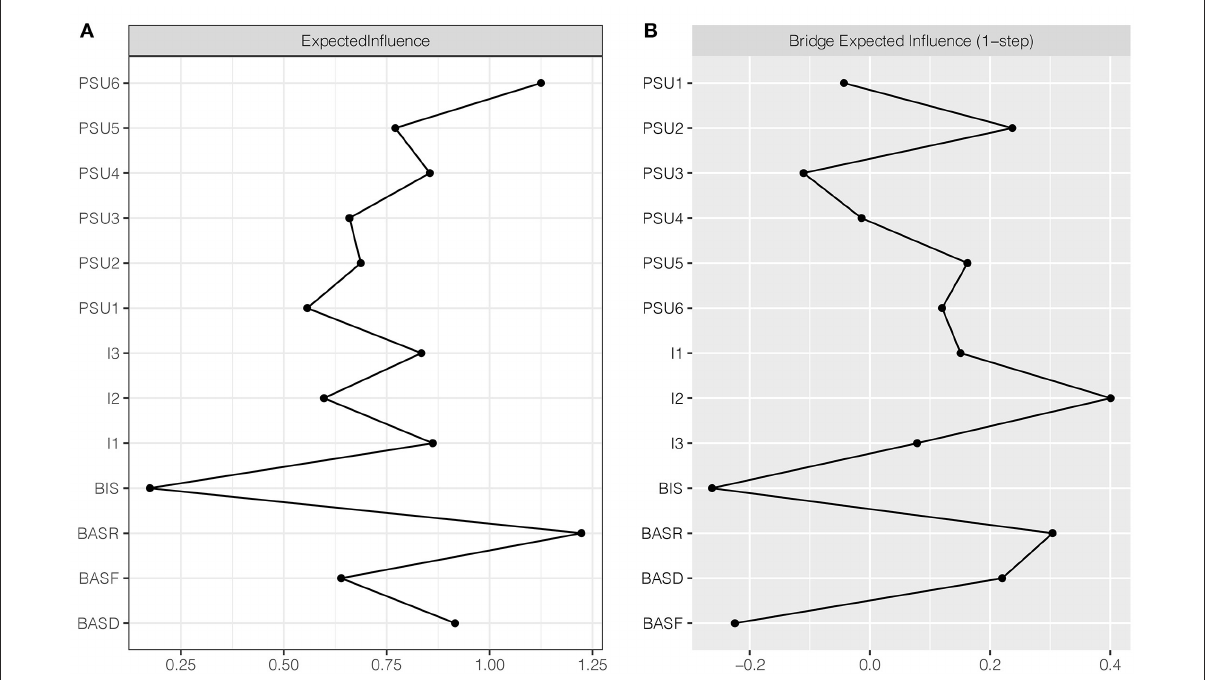
FIGURE2 Centrality plot depicting the expected influence and bridge expected influence of each node in the network (raw value). (A) Expected influence. (B) Bridge expected influence. PSU1, salience; PSU2, conflict; PSU3, mood modification; PSU4, tolerance; PSU5, withdrawal; PSU6, relapse; BIS, Behavioral Inhibition System; BASR, Behavioral Activation System-reward responsiveness; BASD, Behavioral Activation System-drive; BASF, Behavioral Activation System-fun seeking; I1, non-planning impulsivity; I2, motor impulsivity; I3, attentional